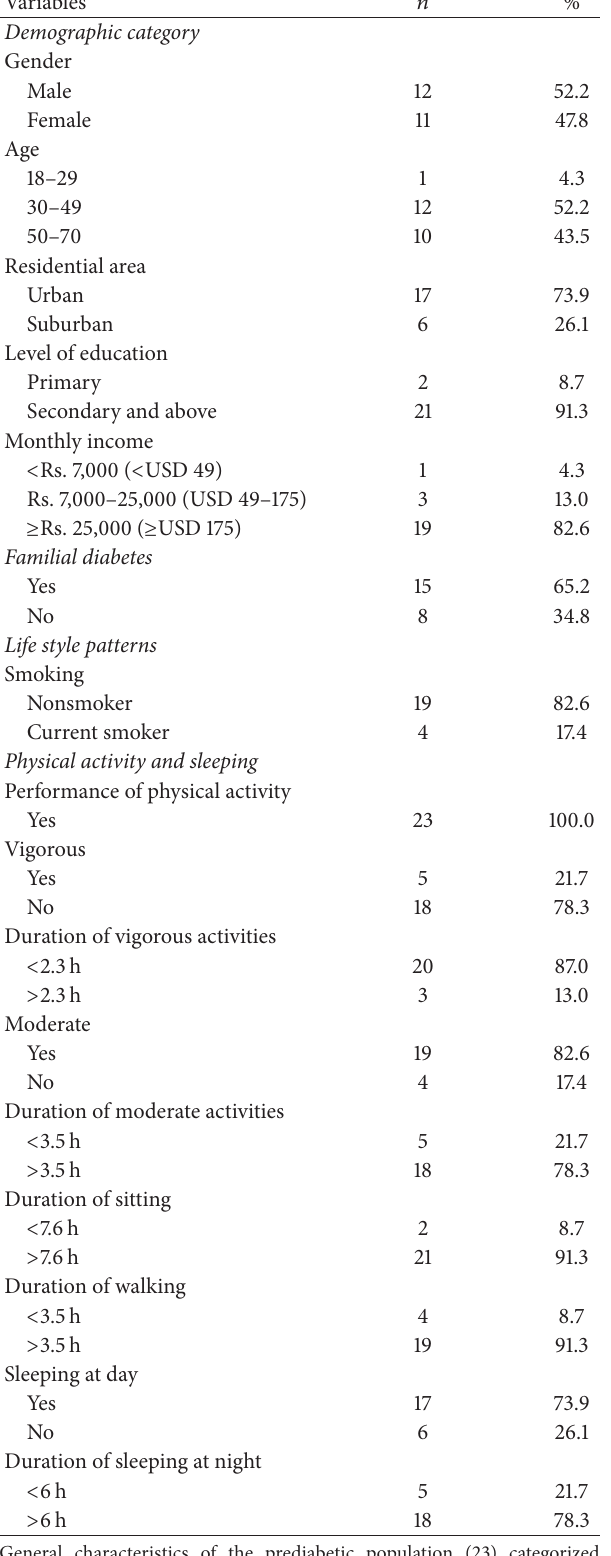
Table2:Sociodemographicandlifestylecharacteristicsamongsub- jects with prediabetes.